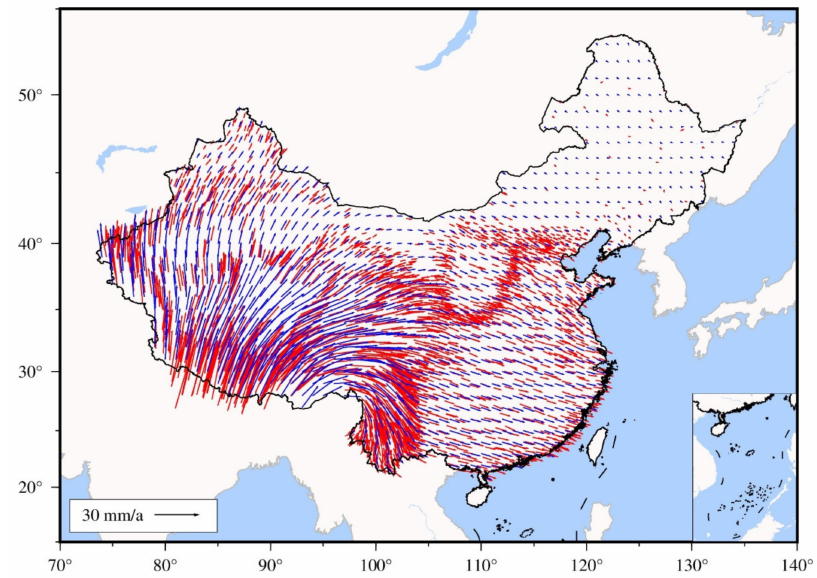
Figure 6. The horizontal grid velocity field (1 ◦ × 1 ◦ ) of continental China (The red arrow is the known velocity, and the blue arrow is the grid